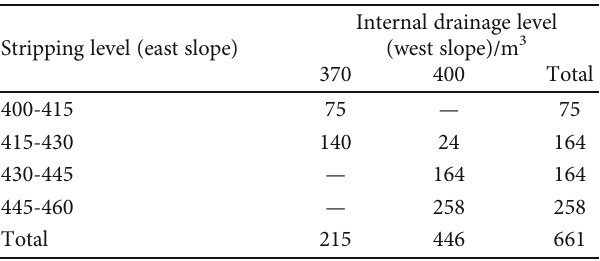
Figure 4: Land saving and loss reducing schemes for south slope. Table 1: Corresponding table for internal discharge of stripping materials on working slope.